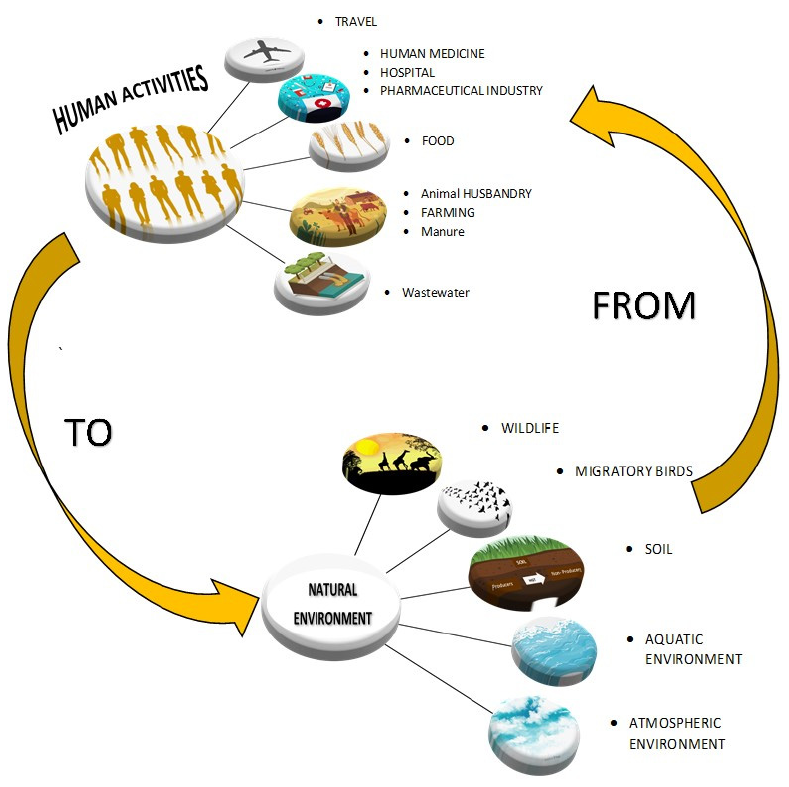
Figure 2. The environmental resistome.